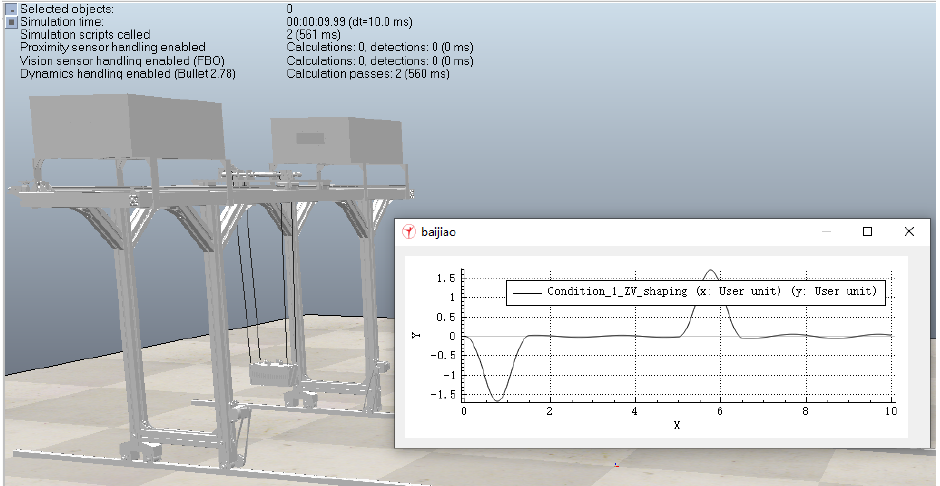
Figure 11. Digital twin RMGC for virtual testing.